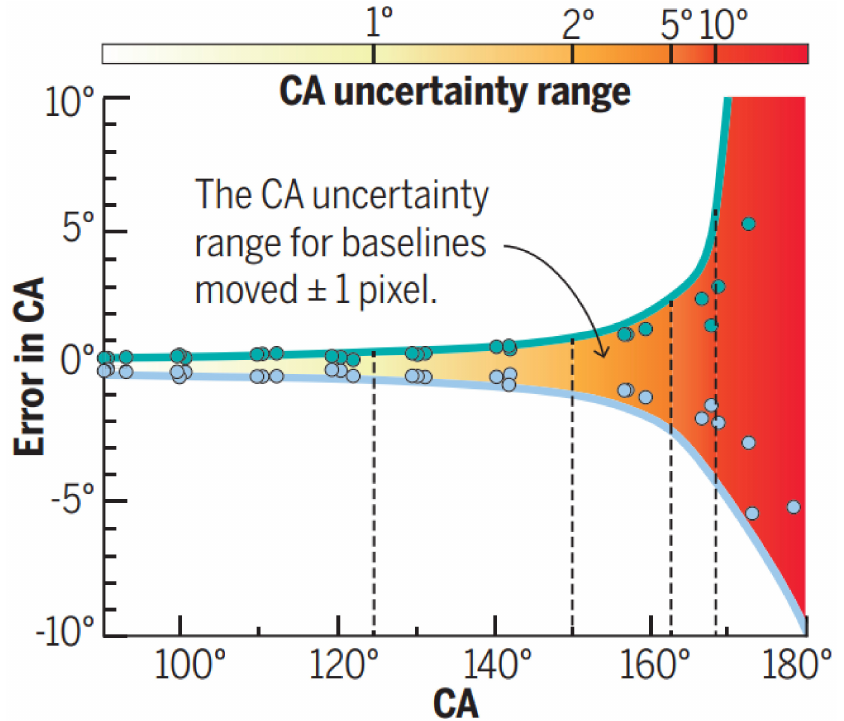
Figure 24. Plot of error in WCA resulting from just 1-pixel error in identifying the correct baseline (i.e., solid/liquid interface). The top curve represents the error for a baseline shifted 1 pixel downward. The bottom curve represents the error for a baseline shifted 1 pixel upward (From [154]. Reprinted with permission from